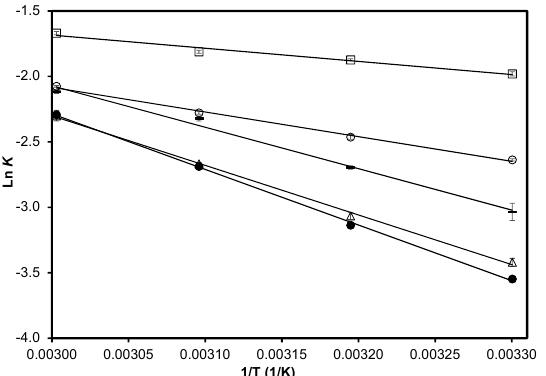
Figure 4. Arrhenius plot of the oxidation of soybean oil. Control with synthetic antioxidant, ; CCF fraction, ; Cashew nut-shell liquid, ; Control without antioxidant, ; FA Fraction, . Data are presented as mean ( n = 3) ± SD. r 2 values range from 0.973 to 0.999. Each slope represents E a /R.